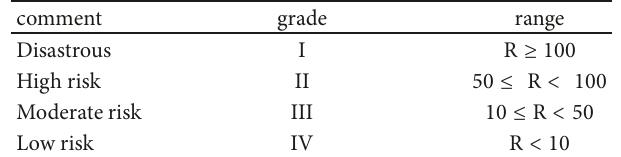
Table 1: Dynamic risk